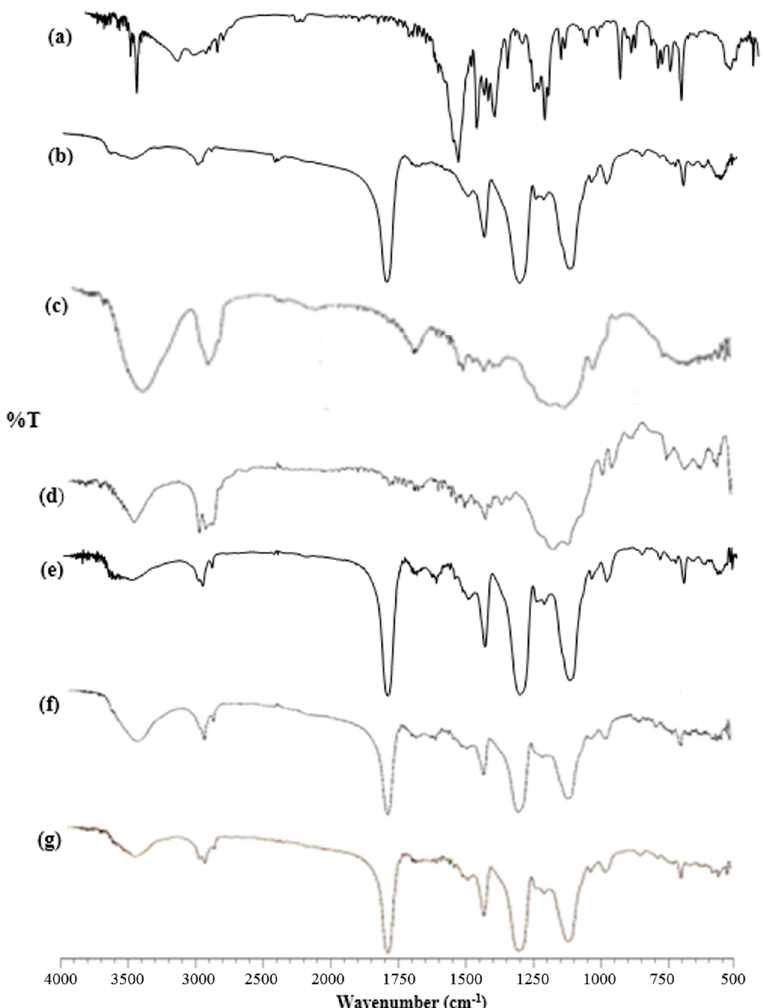
Figure 4. IR spectra of: fenoprofen calcium dihydrate ( a ); TA- β -CD ( b ); HPMC ( c ); EC ( d ); drug-TA- β -CD complex 1:3 ( e ); HPMC/drug complex ( f ); EC/drug complex ( g ). ( ν C–O–C